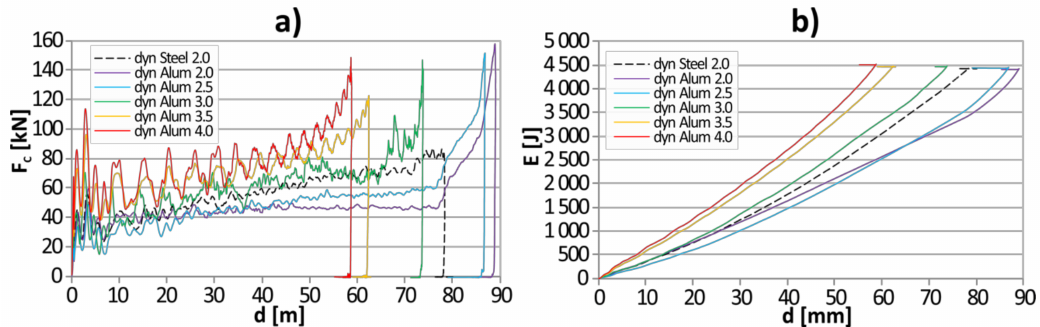
Figure 5. The results of dynamic compression tests: ( a ) E = f(d); ( b ) F C = f(d).